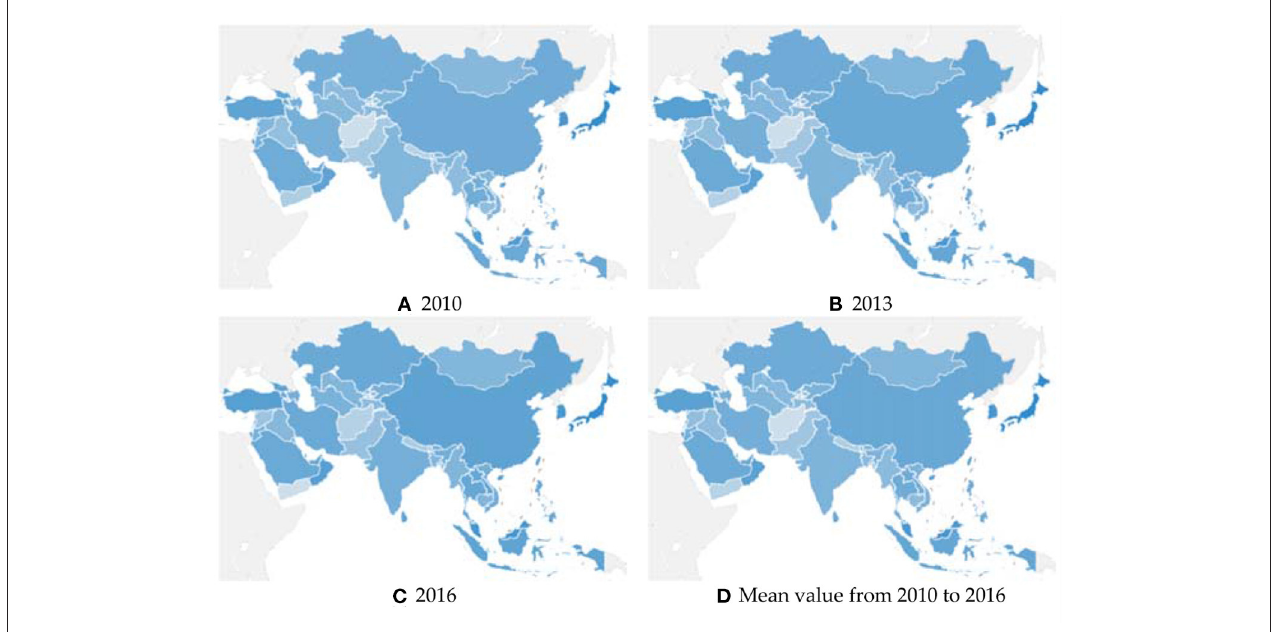
FIGURE 1 | Geographical distribution of GDI in Asia. Subfigure (A) is the geographical distribution of GDI in 2010; (B) is the geographical distribution of GDI in 2013; (C) is the geographical distribution of GDI in 2016; and (D) is the geographical distribution of the mean value of GDI from 2010 to 2016.